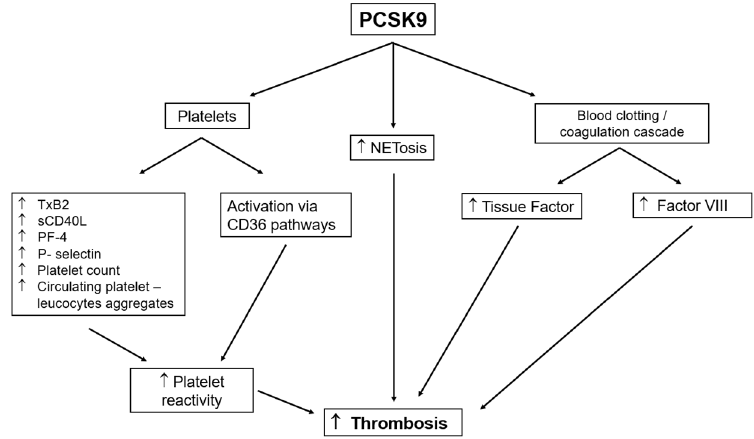
Figure 1. Effects of PCSK9 on platelets and coagulation cascade factors.